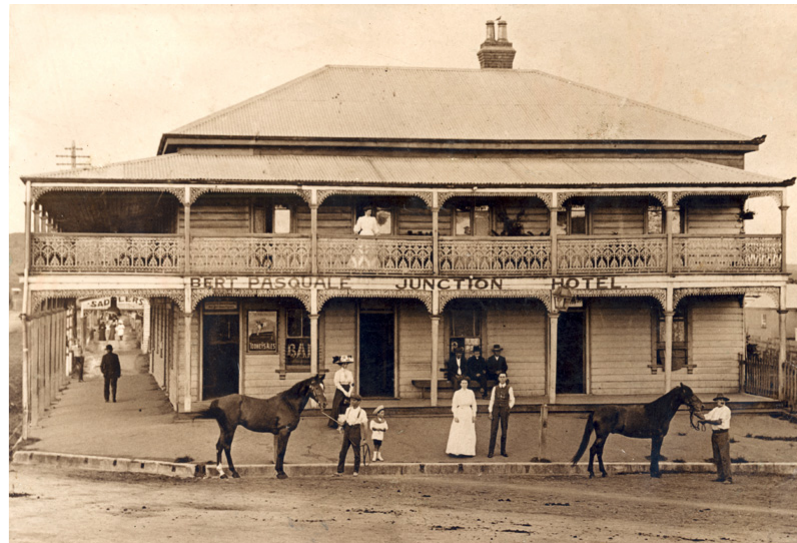
Figure 4: The Junction Hotel